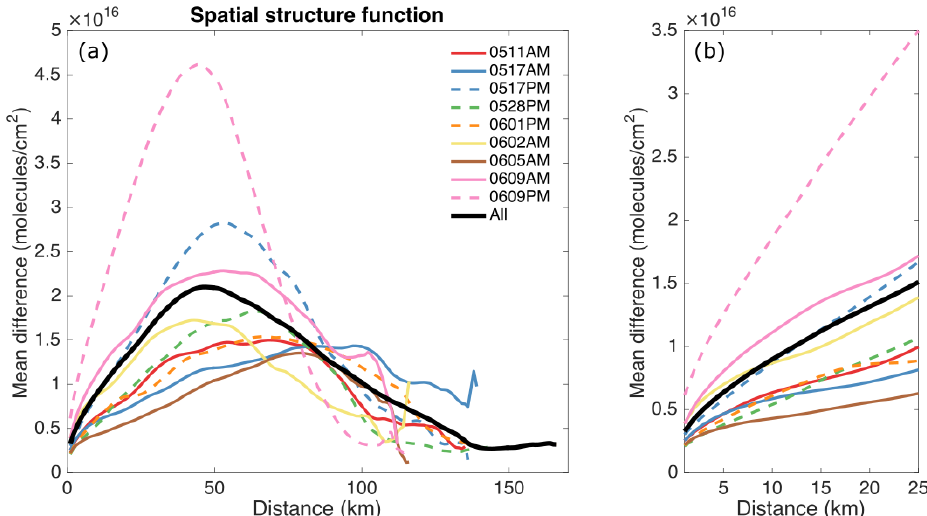
Figure 7. (a) Spatial structure function (SSF) for GeoTASO data of tropospheric NO 2 vertical column (molec.cm − 2 ) over the Seoul Metropolitan Area (SMA) during KORUS-AQ and (b) the zoom-in version of panel (a) for a distance range of 1–25km. The SSF cal- culates the average of the absolute value of NO 2 , VC differences (i.e., mean difference; y axis) across all data pairs (measured in the same hourly bin) that are separated by different distances ( x axis). The SSF based on GeoTASO data measured during morning flights are solid colored lines while the SSF based on GeoTASO data measured during afternoon flights are dashed colored lines. The SSF based on all the data is the solid black